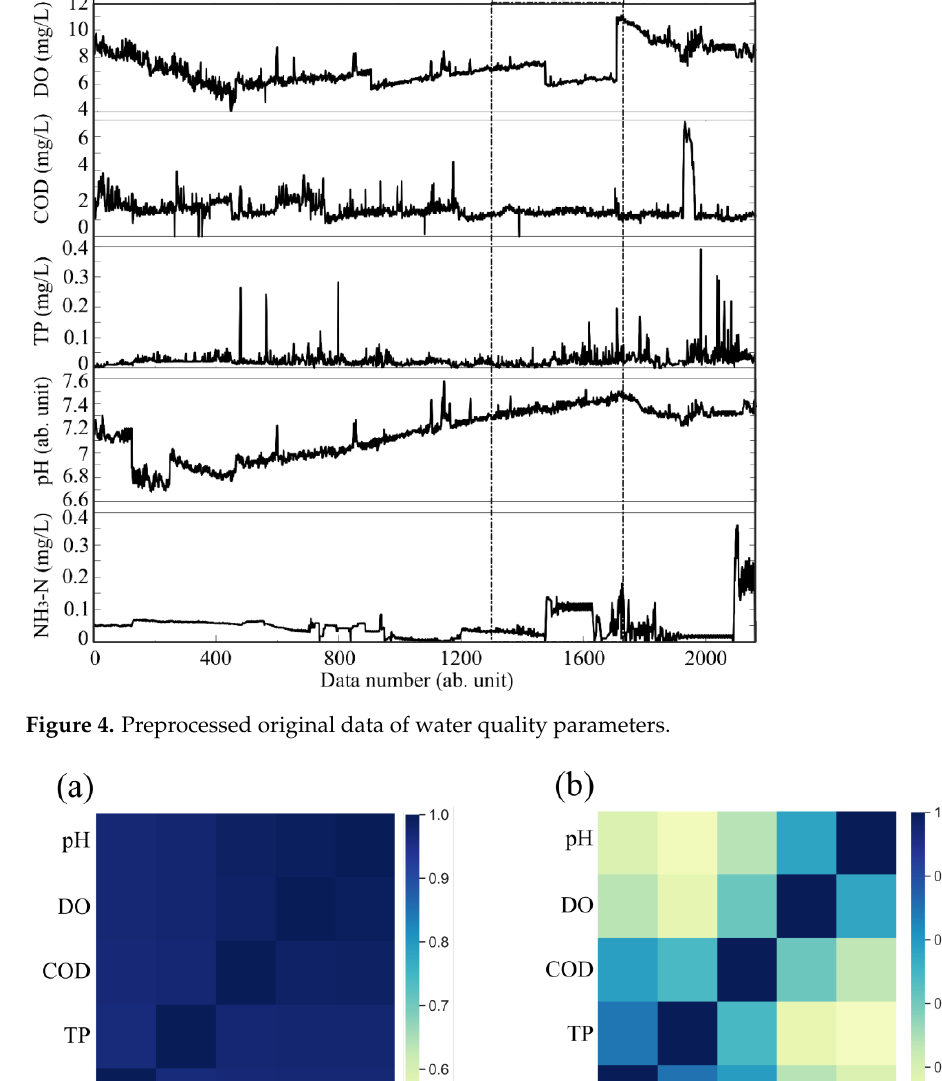
Figure 4. Preprocessed original data of water quality parameters.